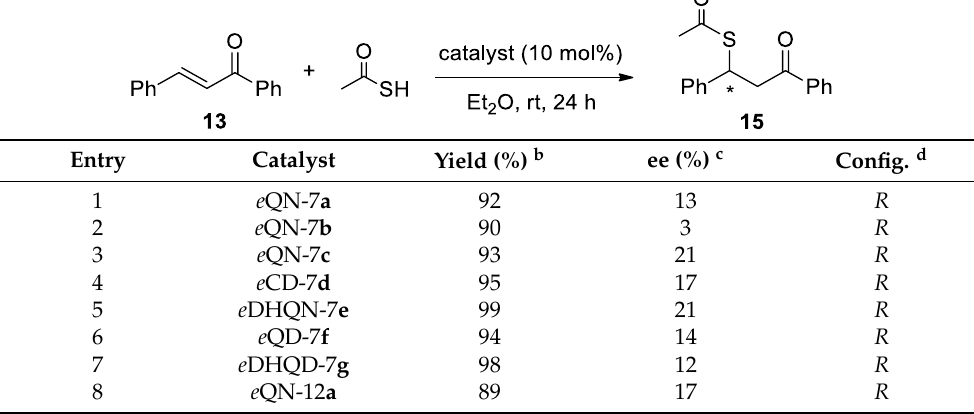
Table 2. Sulfa-Michael addition of thioacetic acid to trans -chalcone a .